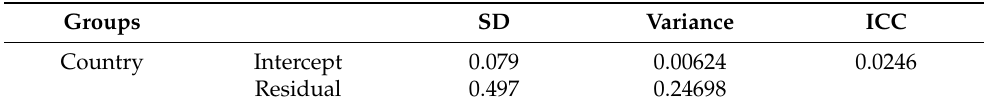
Table 8. Risky sexting: estimates of random component.